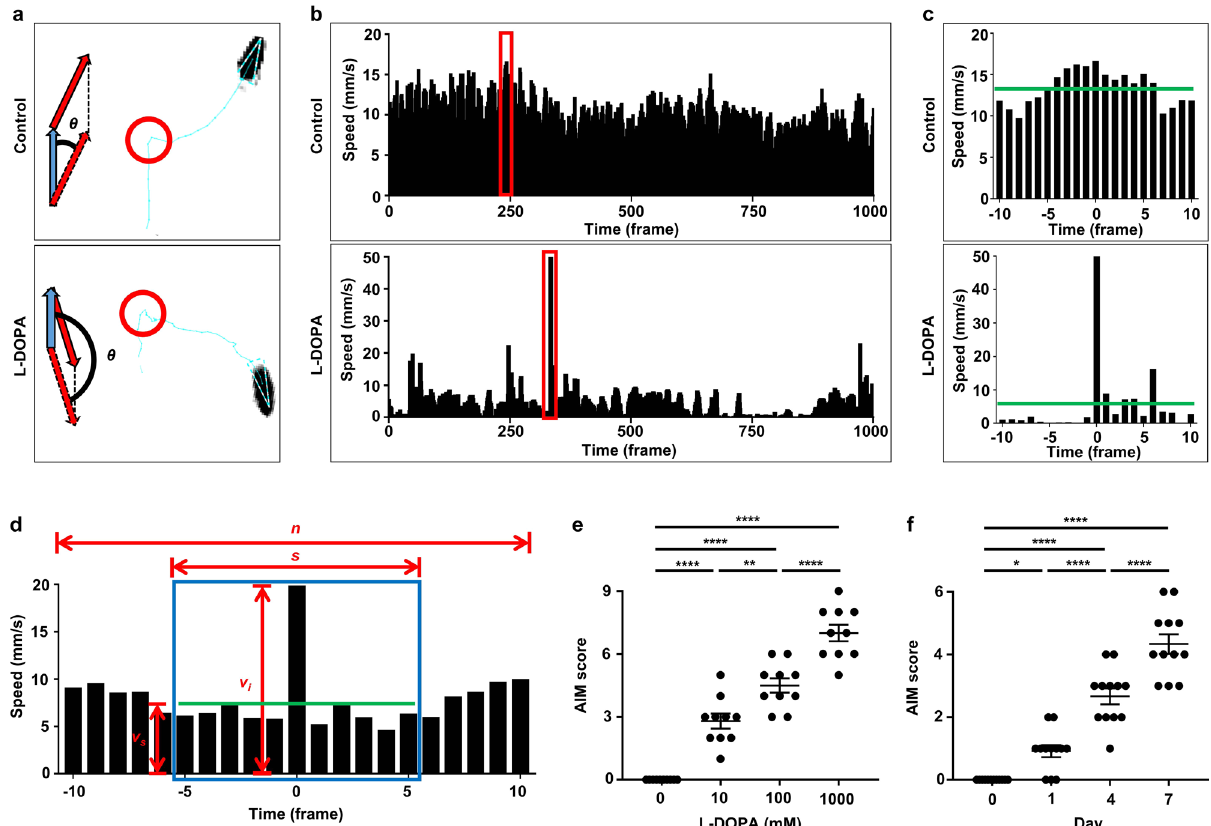
Fig. 2 L-DOPA treatment induces AIMs in Drosophila . a Representative trajectories of a control and an L-DOPA-fed fl y highlighted with their altered directions (red arrows) in comparison to original directions (blue arrow). Red circles depict turning movements. θ indicates the angular difference between the original and altered direction. b Representative instantaneous speeds of a control and an L-DOPA-fed fl y within 1000 frames. Peaks of instantaneous speeds of the control and L-DOPA-fed fl y c are highlighted in red boxes of b . c Zoomed-in instantaneous speeds 10 frames before and after the peaks. Green lines denote the mean speed within 21 frames. d Graphical illustration of the variables from instantaneous speeds to calculate the AIM score: s, speci fi c time period (window); vs, the mean speed in the window; vi, instantaneous speed; n , entire recording time period. Green line indicates the mean speed in the window. e , f Comparisons of the quanti fi ed AIM score by indicated concentrations of L-DOPA ( e ) and time periods of L-DOPA diet ( f ). N = 10 – 12. **** p < 0.0001; ** p < 0.01; * p < 0.05 by one-way ANOVA Tukey ’ s multiple comparison test. Data are presented as means ± SEM. p < 0.05 was considered statistically signi fi